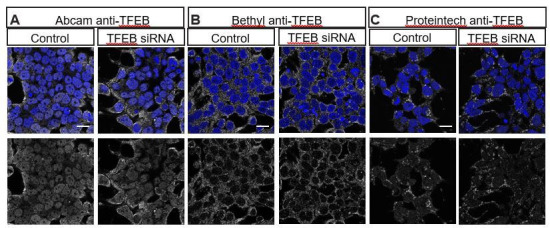
Multiple commercially available TFEB antibodies fail to show specific staining as demonstrated by lack of reduced staining with TFEB siRNA.HEK293T cells stained with (A) Abcam anti-TFEB ab174745, (B) Bethyl anti-TFEB A303-673A and (C) Proteintech 13372-1-AP in control (left) or transfected with TFEB siRNA (ONTarget-Plus, Dharmacon) (right).